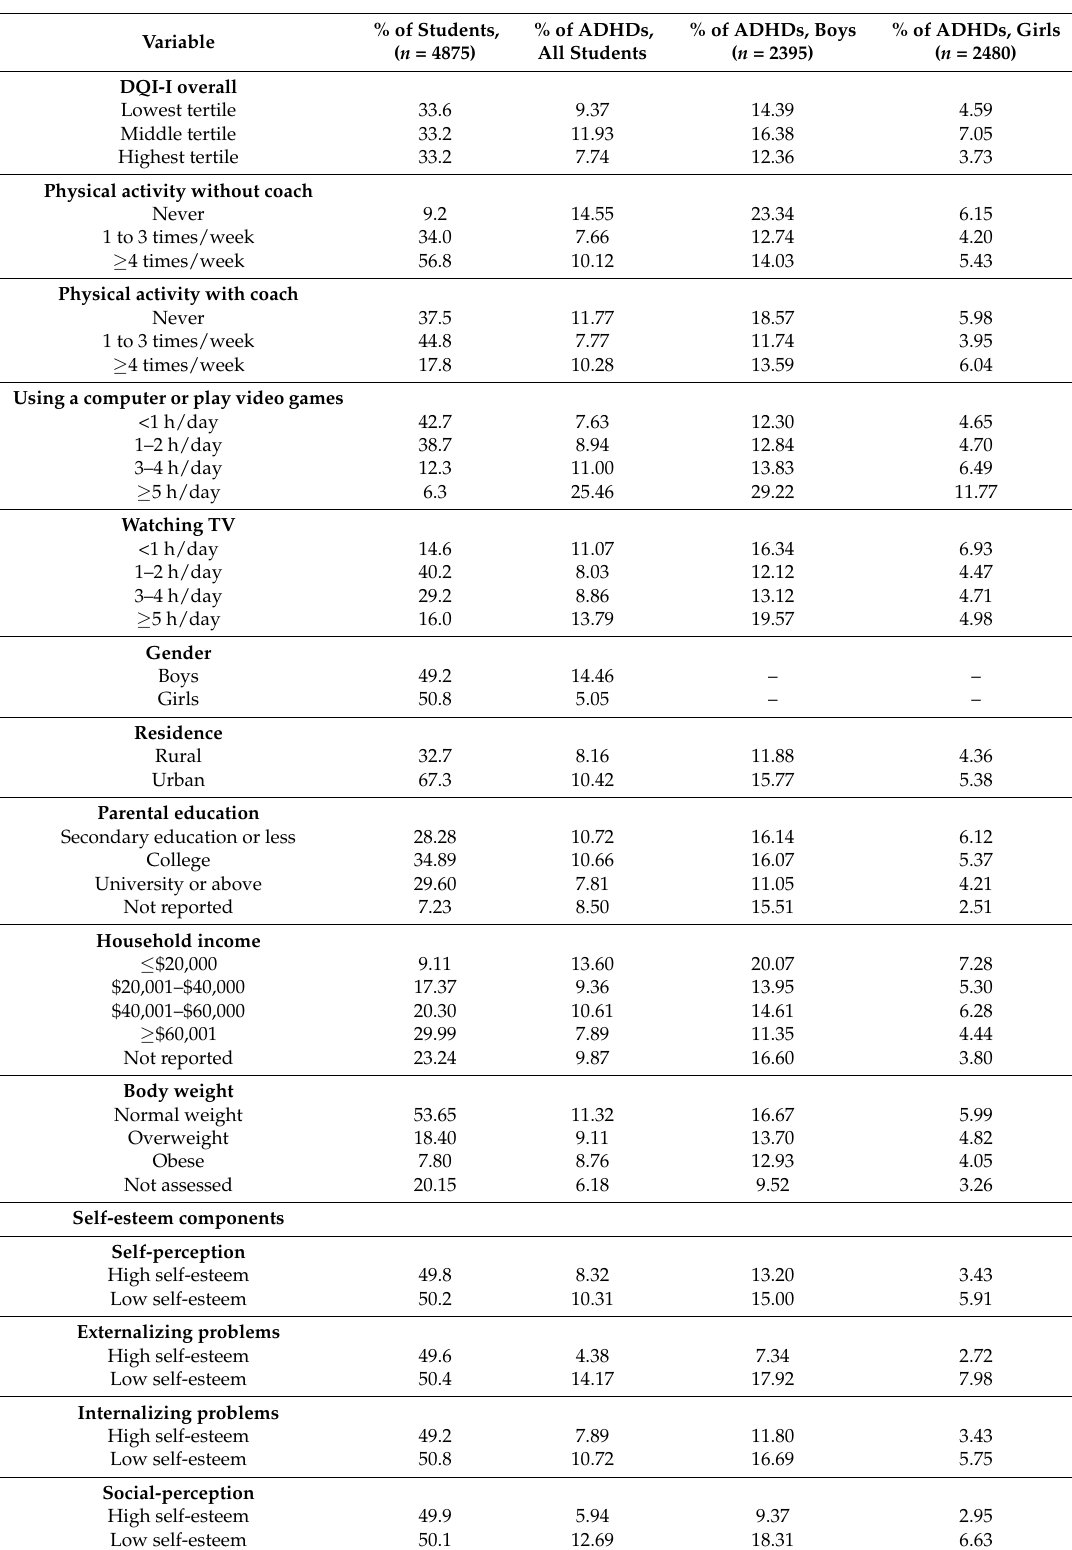
Table 1. Socio-demographic characteristics of the grade five students and percentage (%) of receiving a diagnosis of ADHD, the Children’s Lifestyle and School Performance study, Nova Scotia, Canada. % of Students, % of ADHDs, % of ADHDs, Boys % of ADHDs, Girls Variable ( n = 4875) All Students ( n = 2395) ( n = 2480) DQI-I overall Lowest